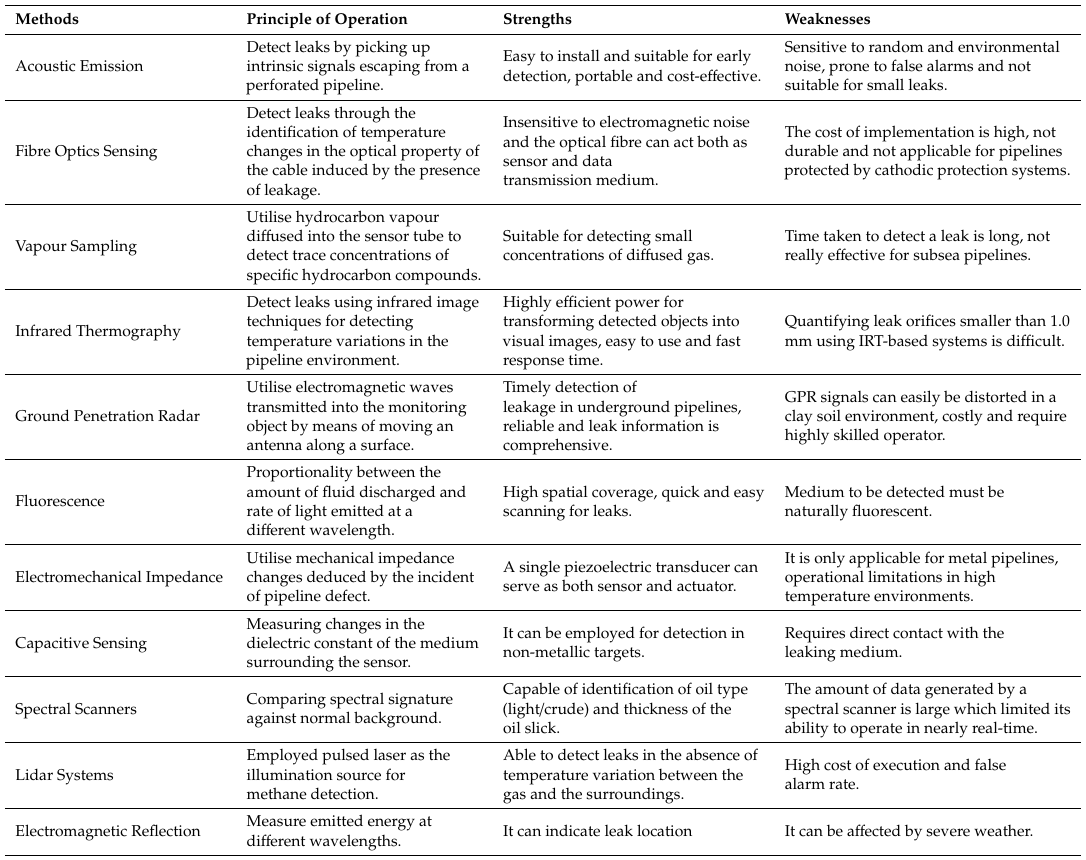
Table 1. Summary of exterior pipeline leak detection